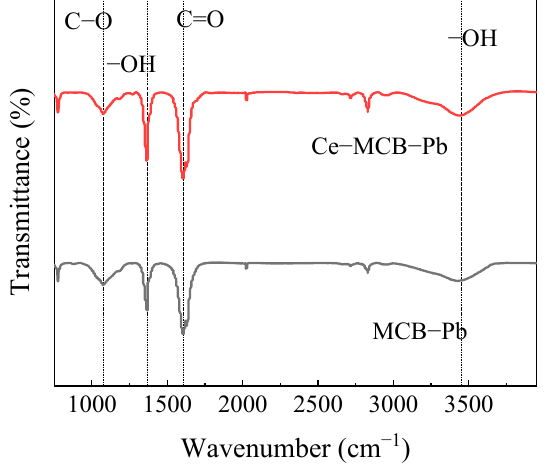
Figure 17. FTIR spectrum of biochar after Pb 2+ absorption.